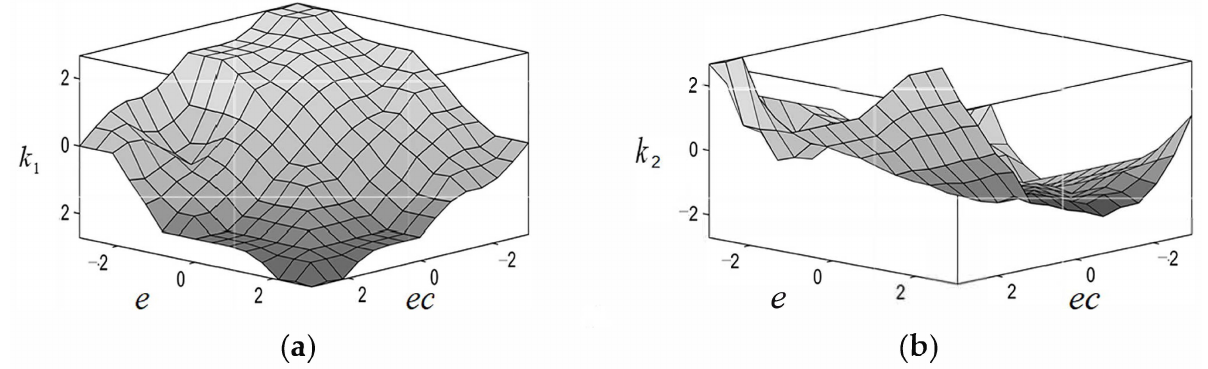
Figure 5. Three-dimensional curve diagram of the control parameters: ( a ) k 1 , ( b ) k 2 .